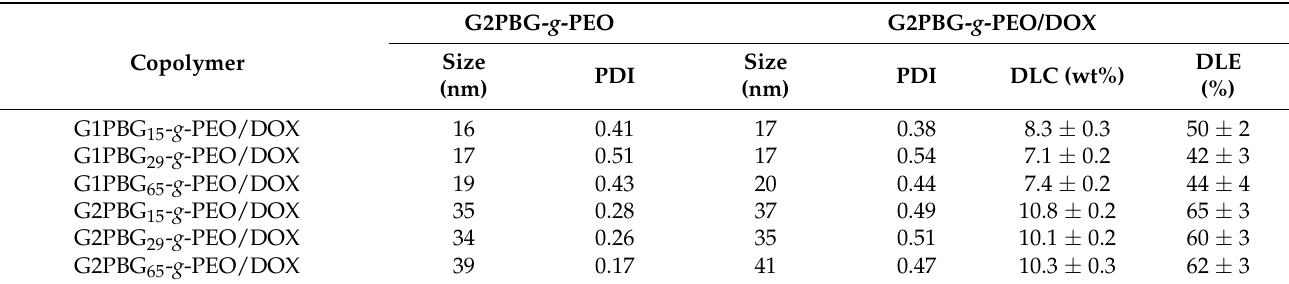
Table 3. Characterization of DOX-loaded unimolecular